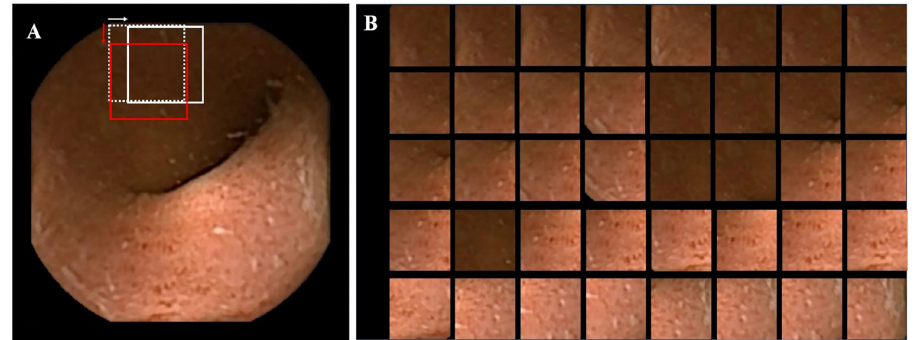
Fig 1. Preparation of dataset. A, An extracted still picture with the size of 576 × 576 pixels. The patch dataset images (128 × 128 pixels) were trimmed from the still picture starting from the left upper corner (white dotted patch), rightwards (white solid patch), then downwards (red solid patch) at every 32-pixel-strides (white and red arrows) over the entire effective region of the still picture. B, A total of 40 patches eligible for